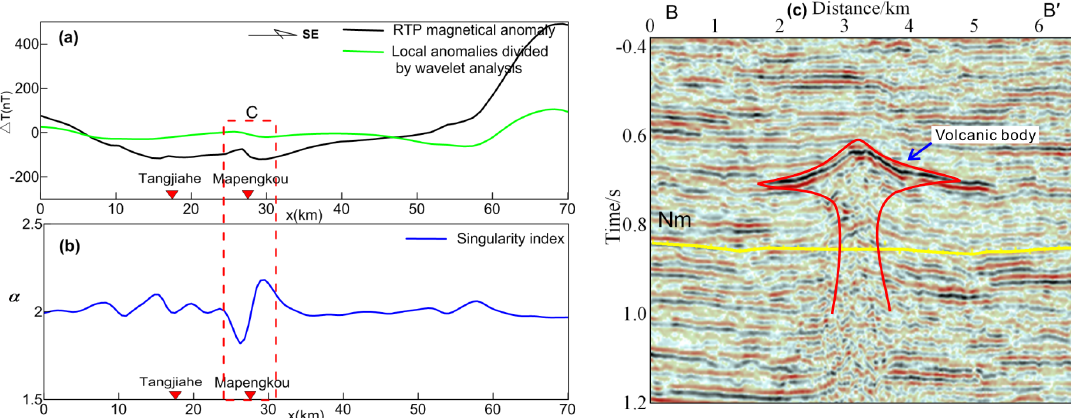
Fig. 12. Illustration of profile A–A 0 : (a) the black line indicates the magnetic anomalies and the green line the local anomalies detected by multiscale wavelet analysis; (b) the blue line represents the singularity indices; and (c) the seismic profile B–B 0 , located in the red dotted box at Mapengkou, the yellow line represents the strata of the Minghuazhen formation.